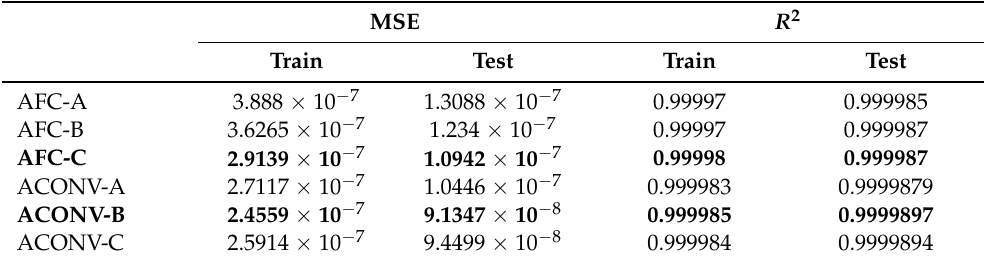
Table 5. Stacked autoencoder results for the dataset 1. The boldface indicates the best results.